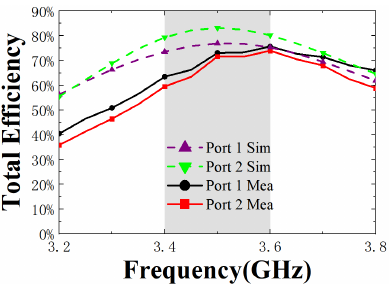
Figure 11. Simulated and measured TE of the proposed antenna.